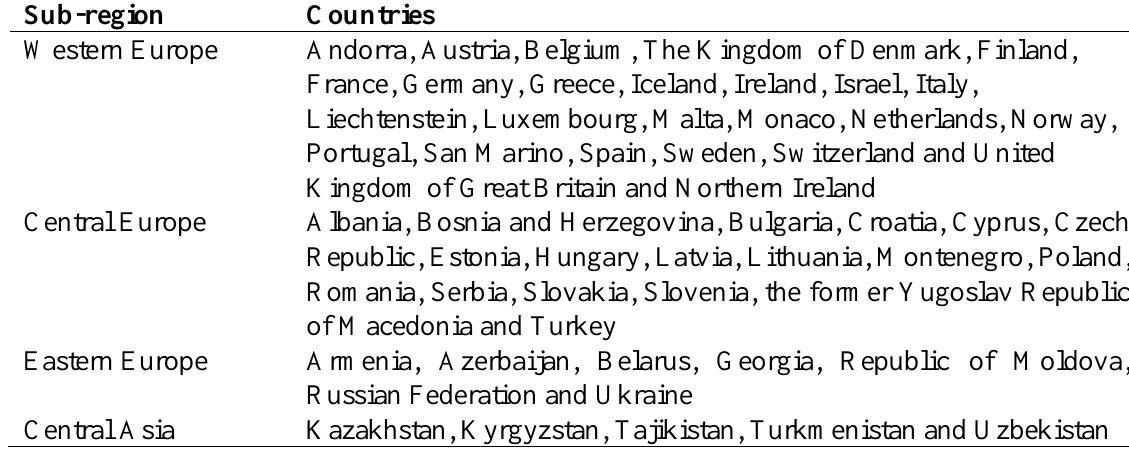
Table A1.1: Countries within each of the IPBES Europe and Central Asia Regional Assessment